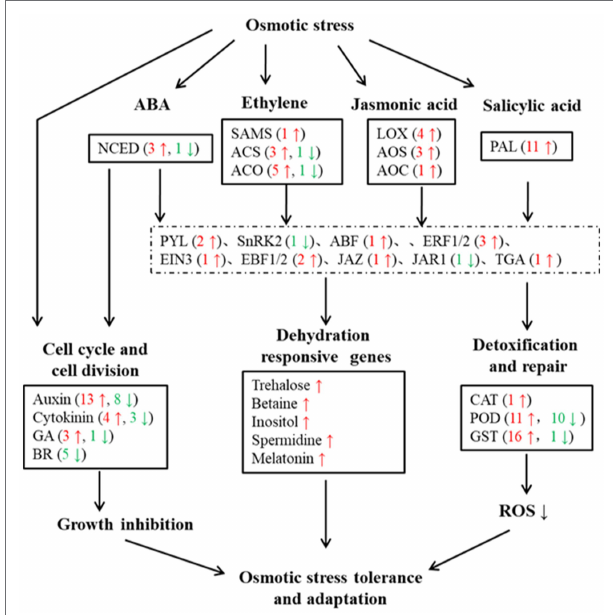
FIGURE 2 | Overview of DEGs under osmotic stress in watermelon cells. Red arrows and numbers represent the number of up-regulated expressed genes and green arrows and numbers represent the number of down- regulated expressed genes.